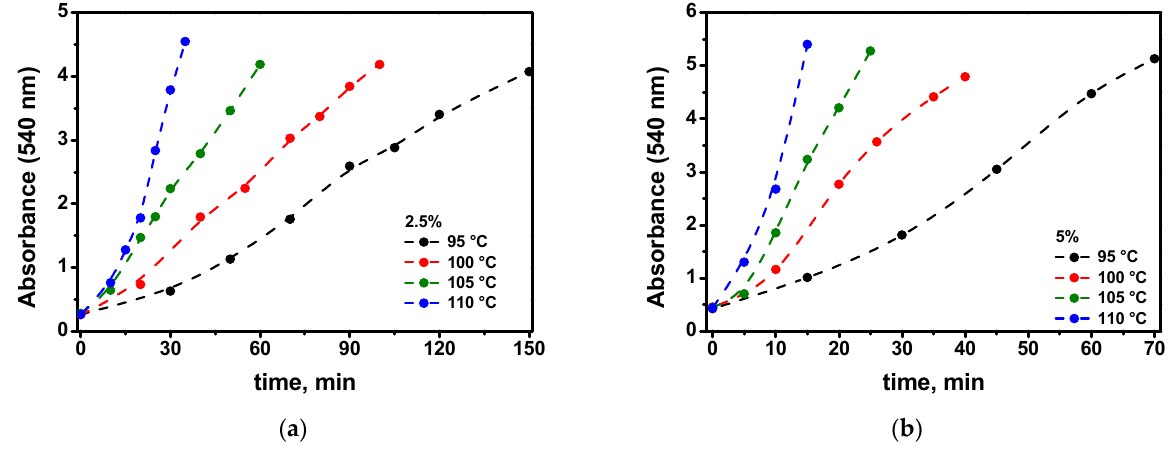
Figure 6. Absorbance of samples polystyrene + (Ph 3 P)Au( n -Bu) 2.5% ( a ) and 5% ( b ) at a wavelength of 540 nm depending on the heating time at four different temperatures.